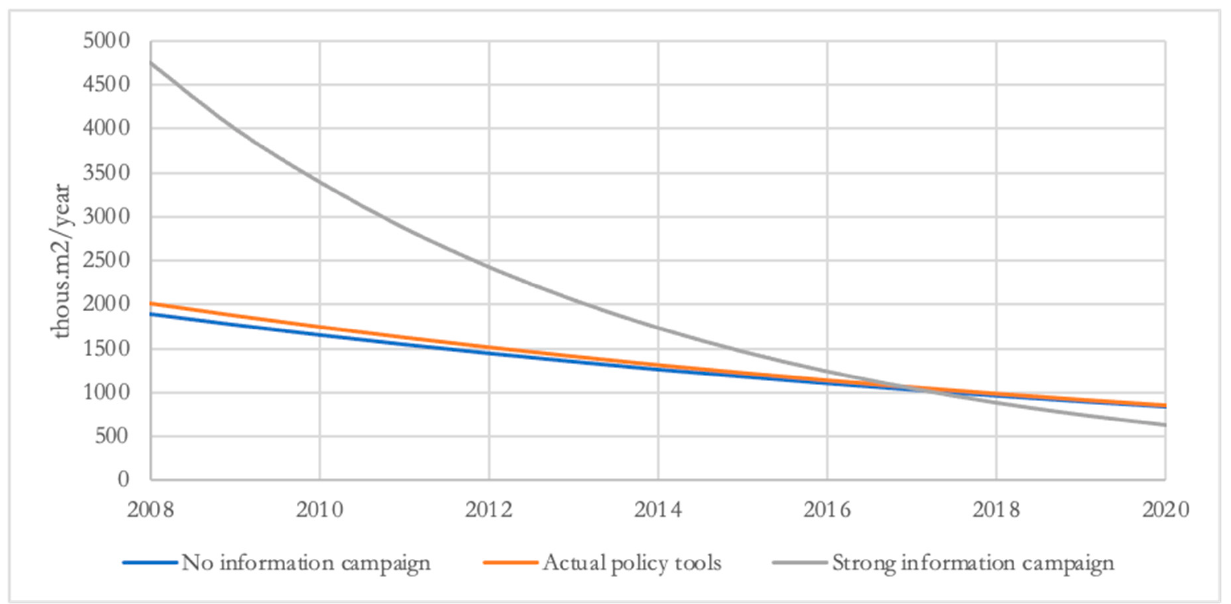
Figure 23. Simulated impact of different types of information campaigns measured as building area represented by the informed inhabitants (not being informed before), in m 2 per year.